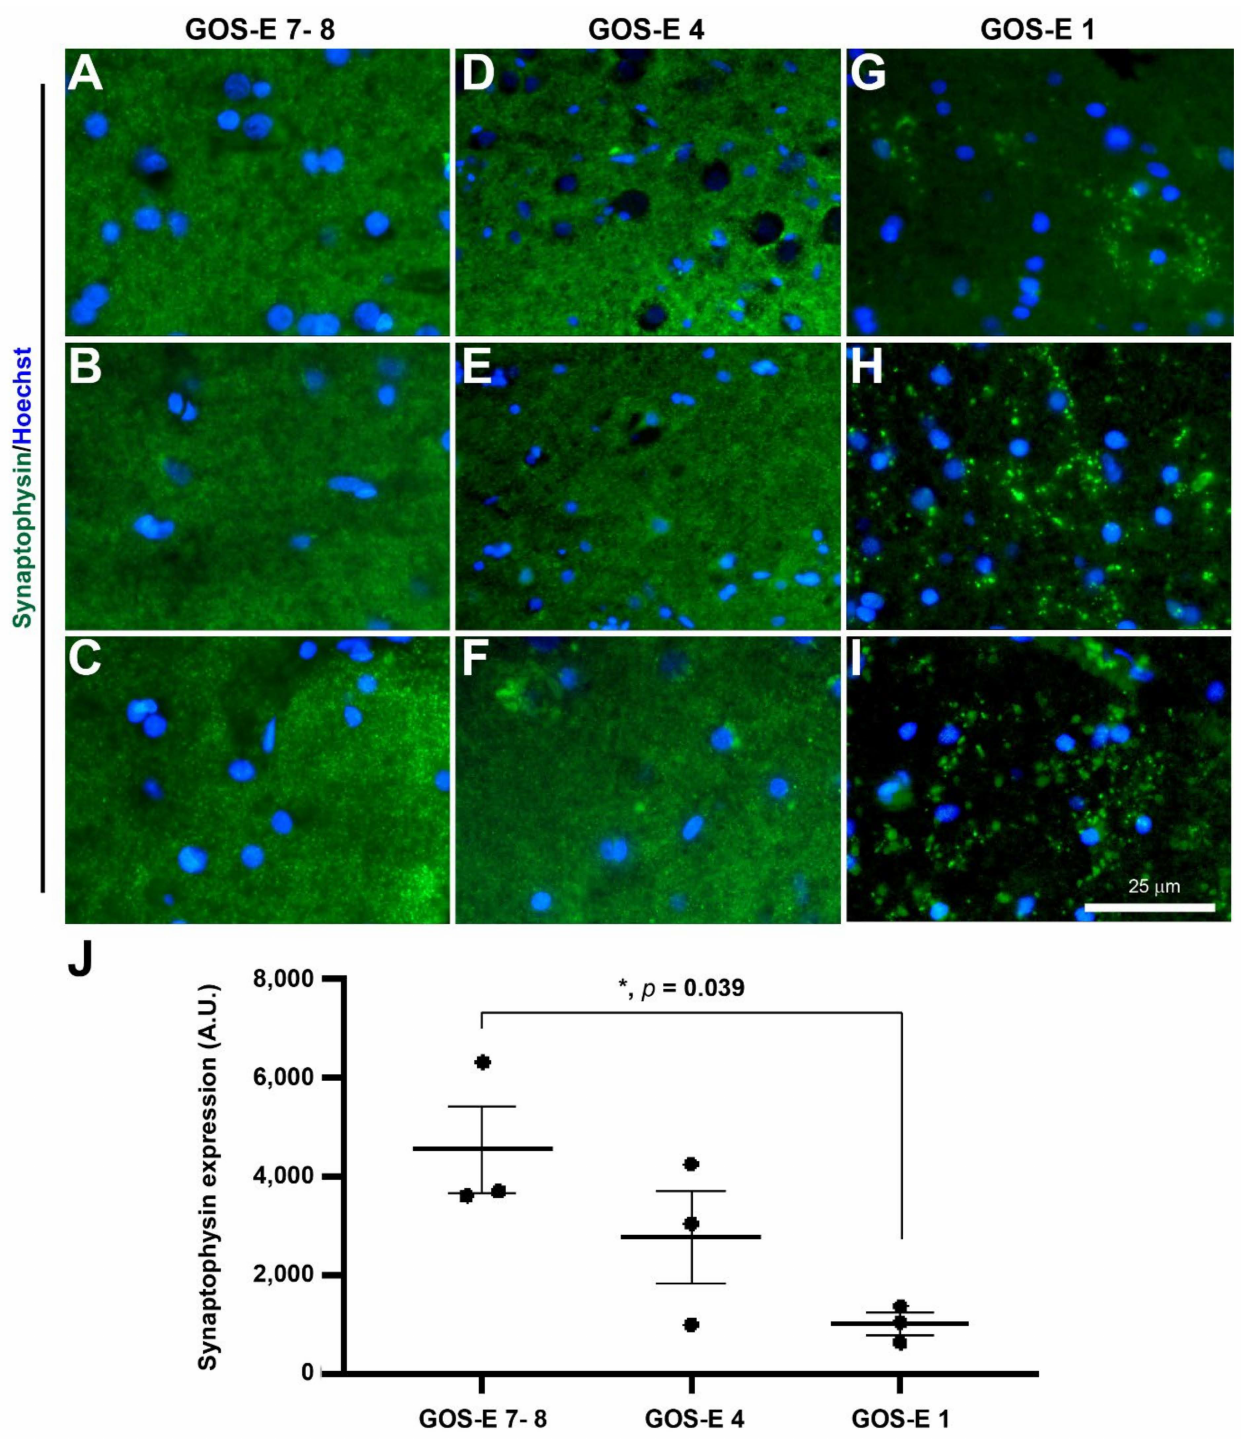
Figure 7. Synaptophysin-immunoreactive synaptic terminal in brain biopsies after severe TBI. Pho- tomicrographs of synaptophysin immunostaining in 3 individual biopsies from patients with a GOS-E 7–8 ( A – C ). Photomicrographs of synaptophysin immunostaining in 3 individual biopsies from patients with a GOS-E 4 ( D – F ). Photomicrographs of synaptophysin immunostaining in 3 individual biopsies from patients with a GOS-E 1 ( G – I ). * p < 0.05, GOS-E 7–8 vs GOS-E 1. Results represent mean ± SEM ( J ). N = 3 per group. Scale bar 25 µ m. Cellular nuclei stained with Hoechst